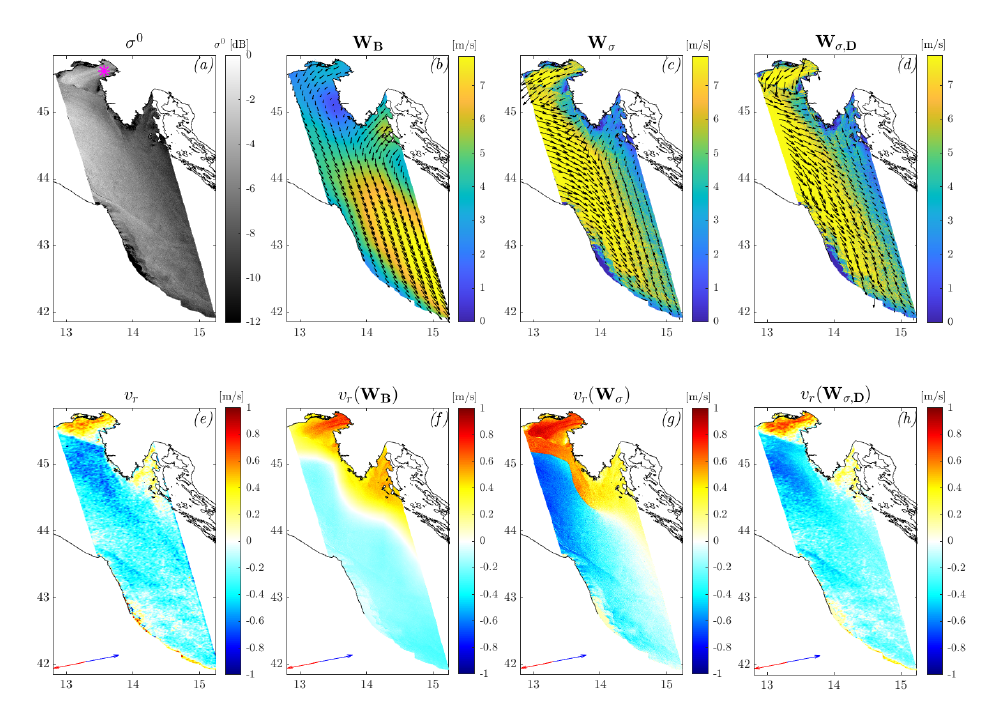
Figure 6. Results related to the ascending acquisition of 16 January 2009 The panel composition follows the one in Figure 4. The magenta star in panel ( a ) indicates the location of ARPA FVG-OSMER e GRN buoy [57].